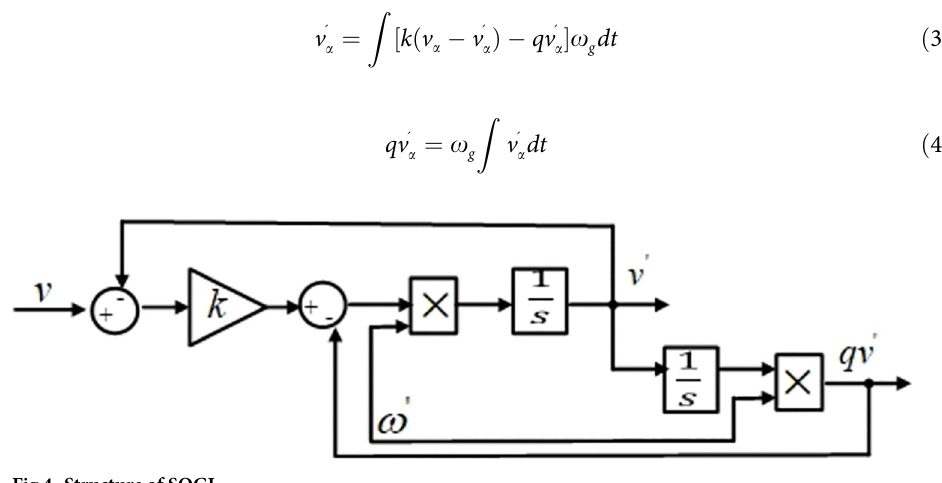
Fig 4. Structure of